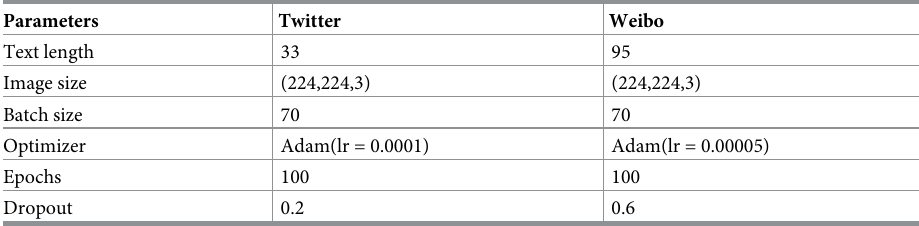
Table 2. Hyperparameters used in model